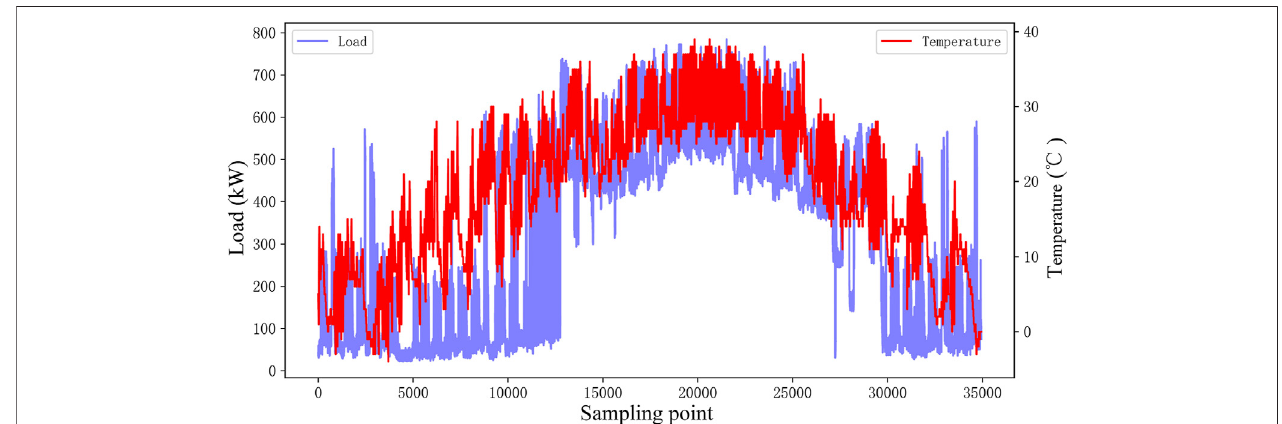
FIGURE 3 | Load and temperature pro fi